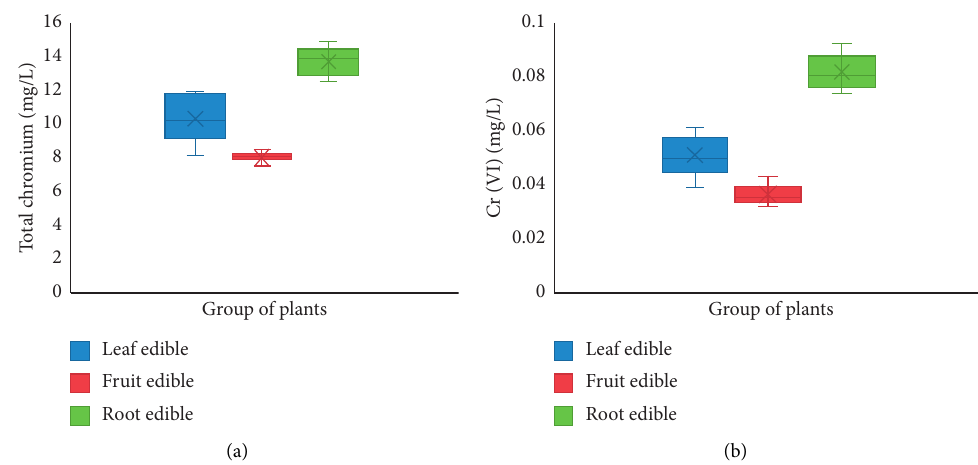
Figure 4: Boxplot showing the variability of chromium concentration among plant types ((a) total chromium; (b) Cr